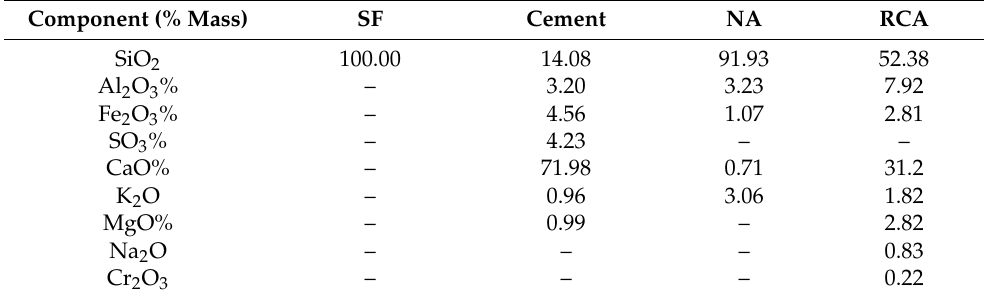
Table 1. Material chemical composition.